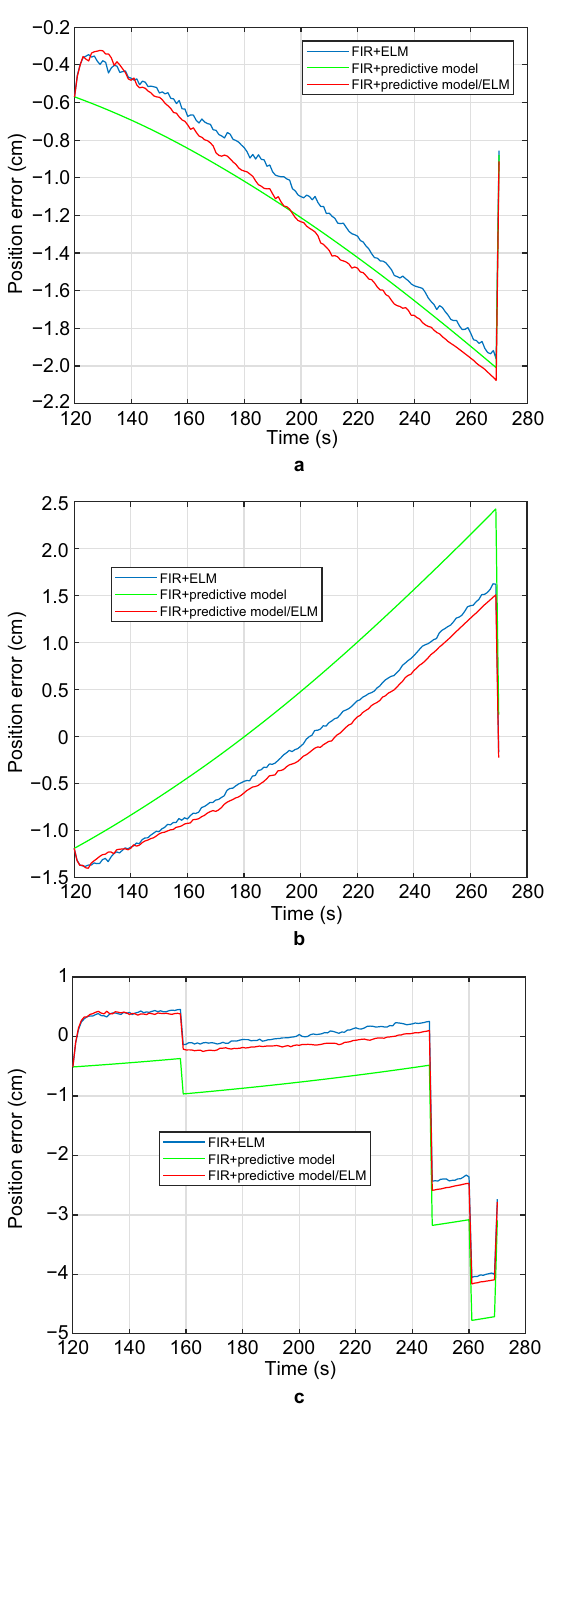
ELM, + predictive model/ELM in #1 UWB +